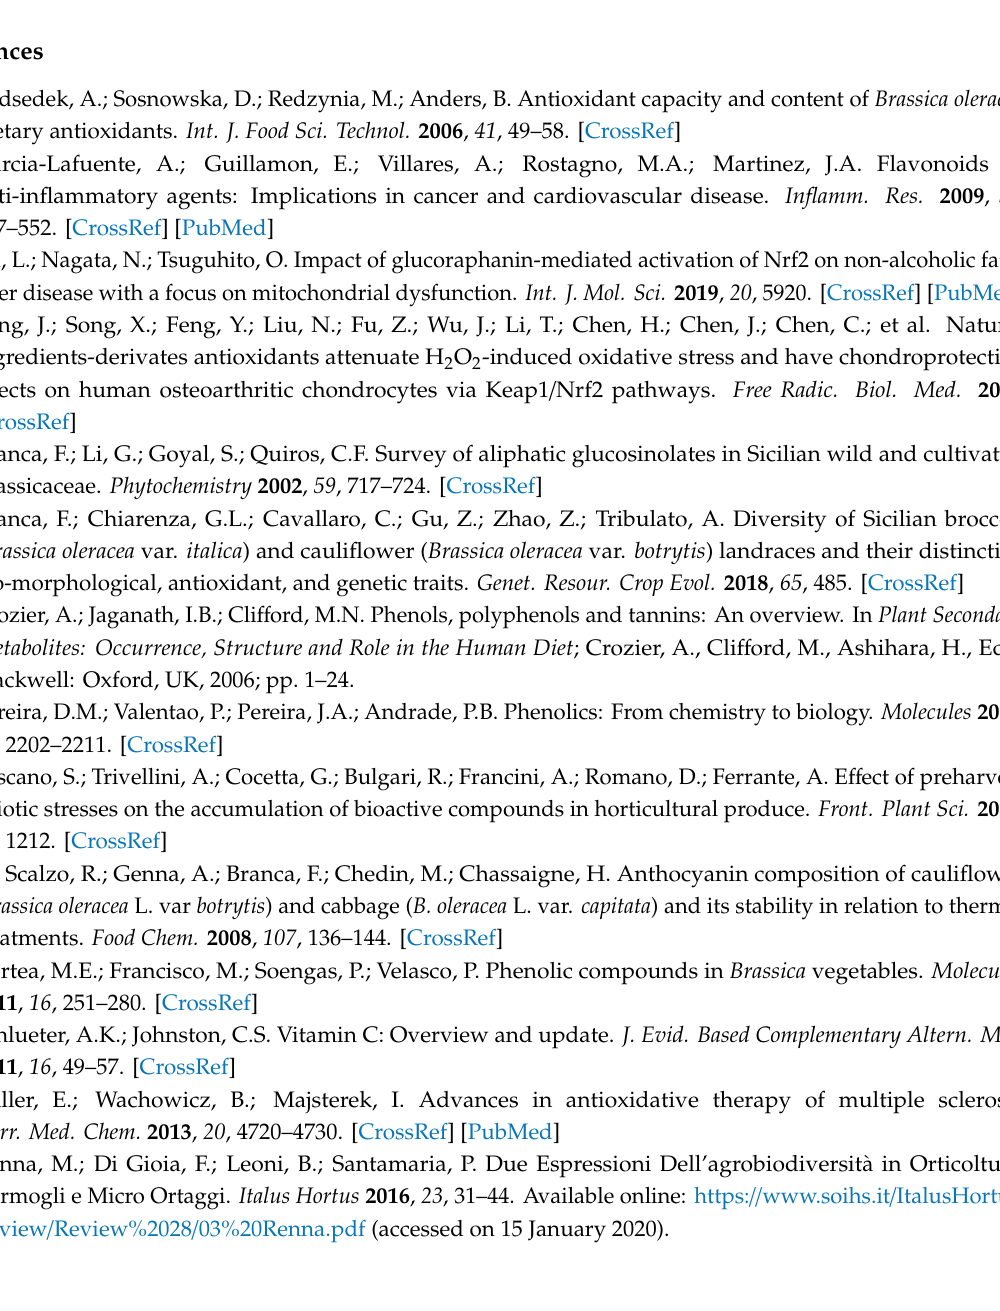
Figure S1: Di ff erent growth plant stages of the Sicilian landrace ‘Broccolo nero’ (BN): from the top to bottom, sprouts, microgreens and baby